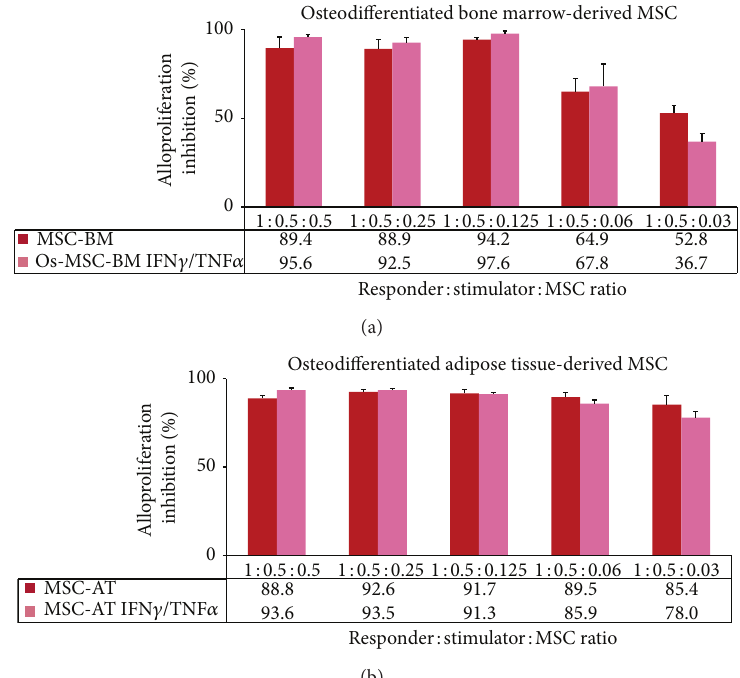
Figure 8: Both BM- andAT-derived MSCs when committed to osteodifferentiation process keep their immunosuppressive properties. PBMC from healthy individuals were used as responder cells towards irradiated LCL ∗ used as stimulating cells in presence of either osteodifferentiated BM-derived MSCs (Os-MSC-BM) or AT-derived MSCs (Os-MSC-AT) that were pretreated with IFN 𝛾 and TNF 𝛼 (IFN 𝛾 /TNF 𝛼 ) or not and used as third-party cells at various responder :stimulator: MSC ratios. Results are given as mean percentage of alloproliferation inhibition ± s.e.m. when compared to PBMC+LCL ∗ using PBMC from 3 and 5 distinct healthy donors in BM- and AT- derived MSCs experiments,